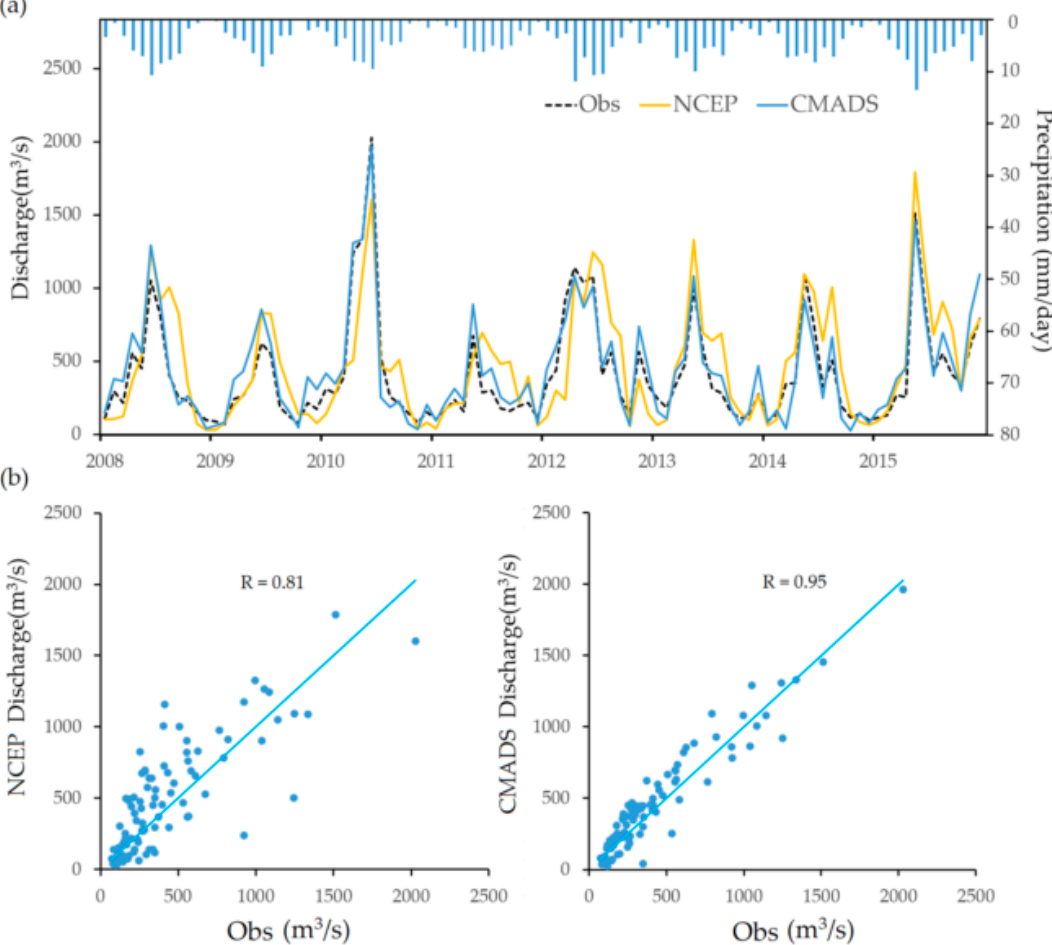
Figure 6. ( a ) Monthly observed discharge and simulated discharge of National Centers for Environmental Prediction (NCEP)-driven and China Meteorological Assimilation Driving Datasets for the SWAT model (CMADS)-driven LSM-HMS in Xiashan during 2008–2015, with the NCEP precipitation shown at the top, ( b ) the scatter plot of observed discharge against NCEP-driven simulation (left) and CMADS-driven simulation (right).